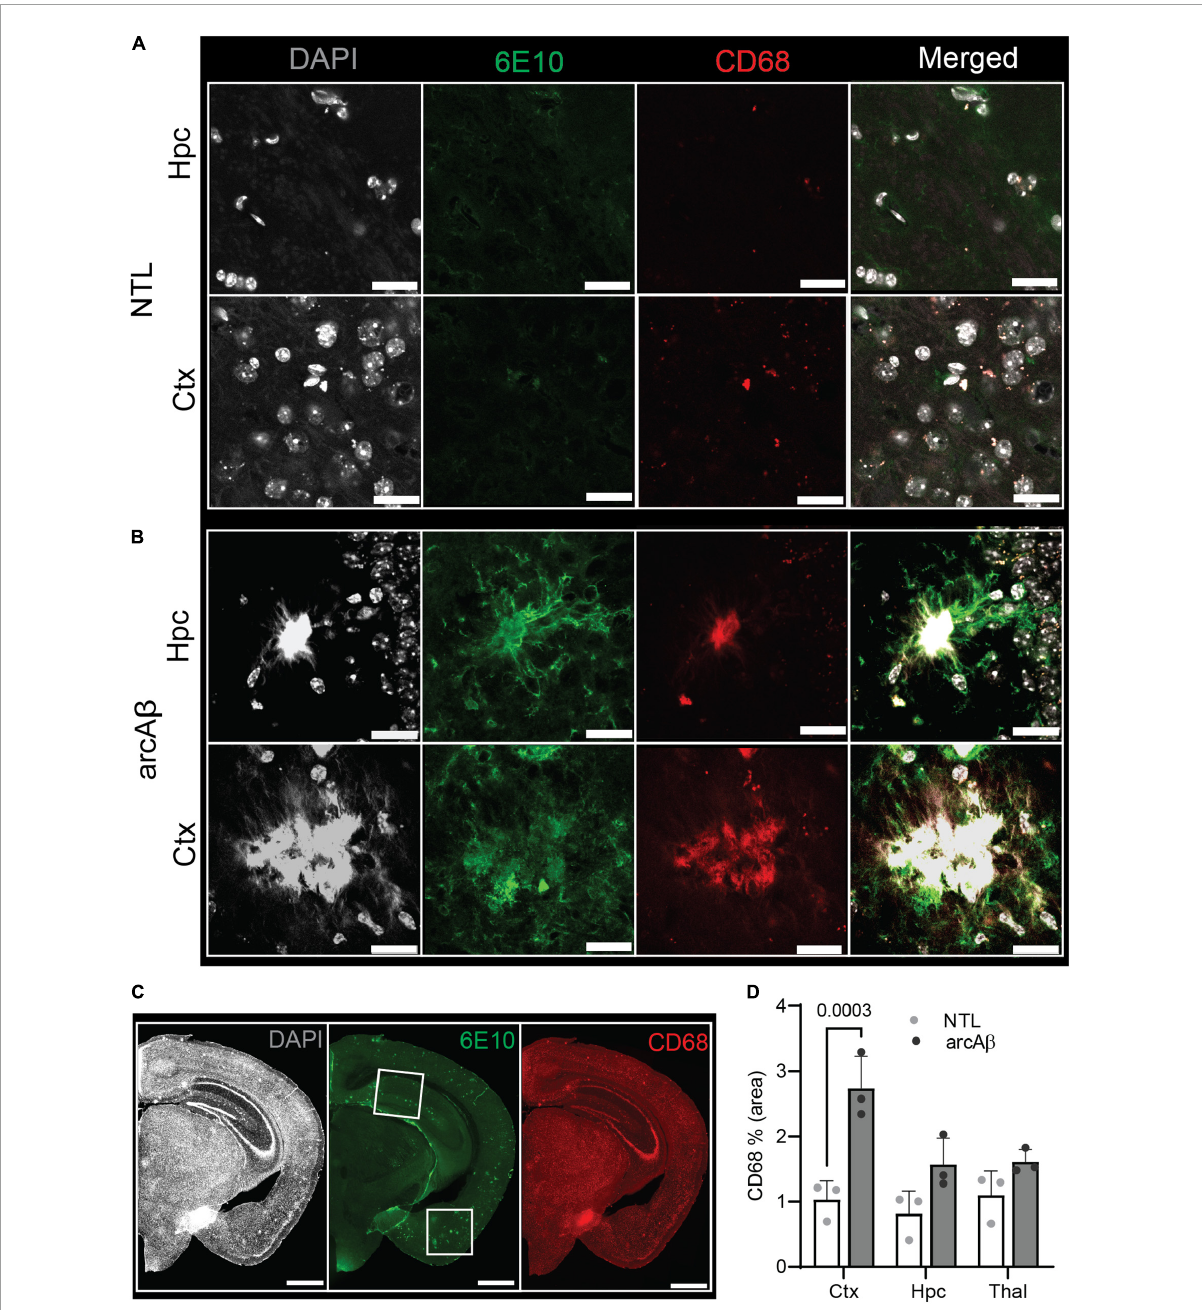
FIGURE3 Microgliosis in the 17-month-old arcA β mouse brain. (A–C) Brain tissue sections of non-transgenic littermate (NTL, n = 3) and arcA β mice ( n = 3) were stained for 6E10 (green)/CD68 (red) in the hippocampus (Hpc) and cortex (Ctx). White boxes in panel (C) indicate the regions including cortex (Ctx), cornu ammonus 1 (CA1) region of the hippocampus (Hpc) that zoomed-in in panels (A,B) . Nuclei were counterstained with DAPI (white). Scale bar = 20 µ m (A,B) , =1 mm (C) . (D) Quantification of CD68 signals in the Hpc, Ctx, and thalamus (Thal) of arcA β mice compared to NTL mice confirmed microgliosis in arcA β